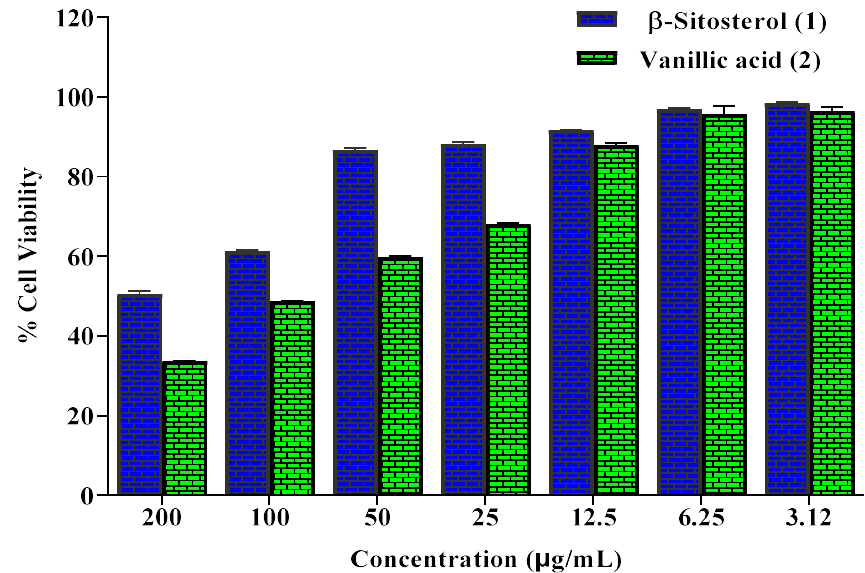
Figure 2. Percentage cell viability of HepG2 cells in MTT assay exhibited by β-sitosterol ( 1 ) and vanillic acid ( 2 ) isolated from D. bupleuroides.